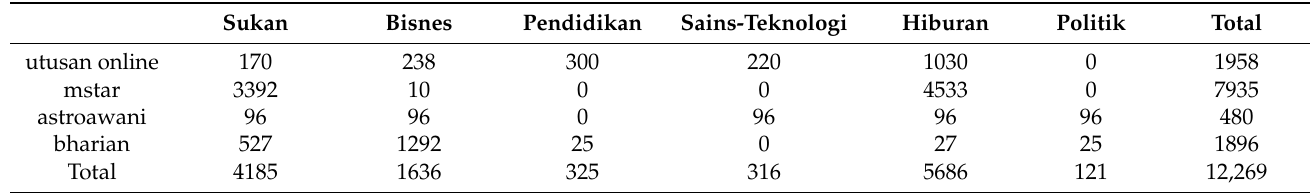
Table 2. Number of collected documents from each website for the classes of